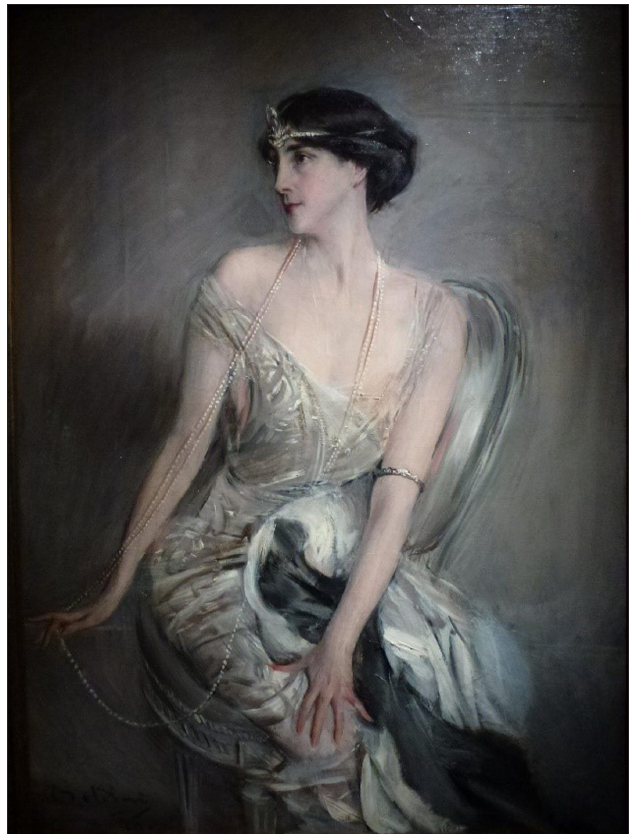
Fig. 6 : Giovanni Boldini, Portrait of Madame G. Blumenthal , Paris, 1896, oil on can- vas, 120 × 85 cm, Musée d’Orsay, Paris (inv. JdeP